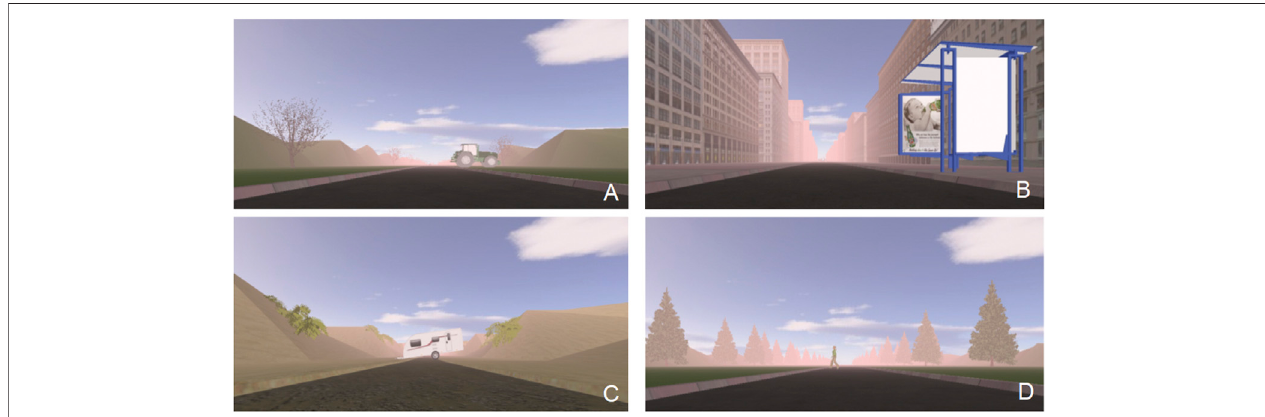
FIGURE 1 | Left to right: Examples of the four road types and objects within them; (A) parkland lane with LM (a tractor) on the right, (B) urban road with LM (bus stop) on the right; (C) sandy countryside path with EP (camper trailer) at the end of the road, (D) forest trial with a virtual agent crossing the road.